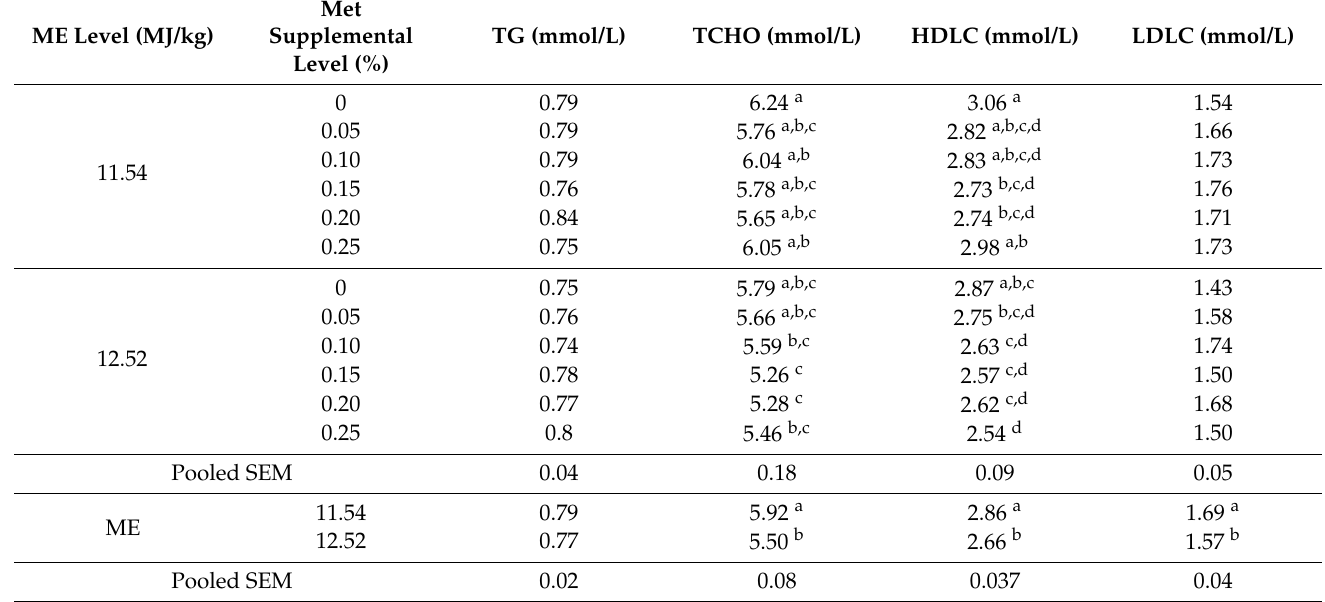
Table 5. Effects of dietary metabolizable energy and methionine levels on lipid metabolism-related biochemical parameters of starter Pekin ducks at 21 days of age 1,2